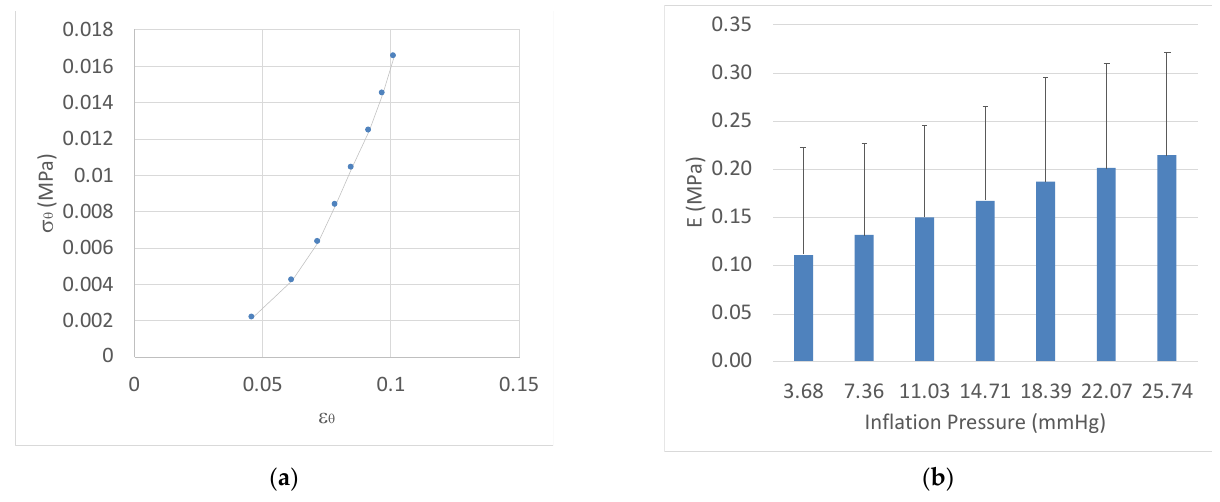
Figure 6. ( a ) Stress ‐ strain curves for untreated corneas obtained from the average data in Table 3 using the shell theory; ( b ) secant elastic modulus, E, for the applied pressures during inflation tests. Error bars in ( b ) are standard deviations.